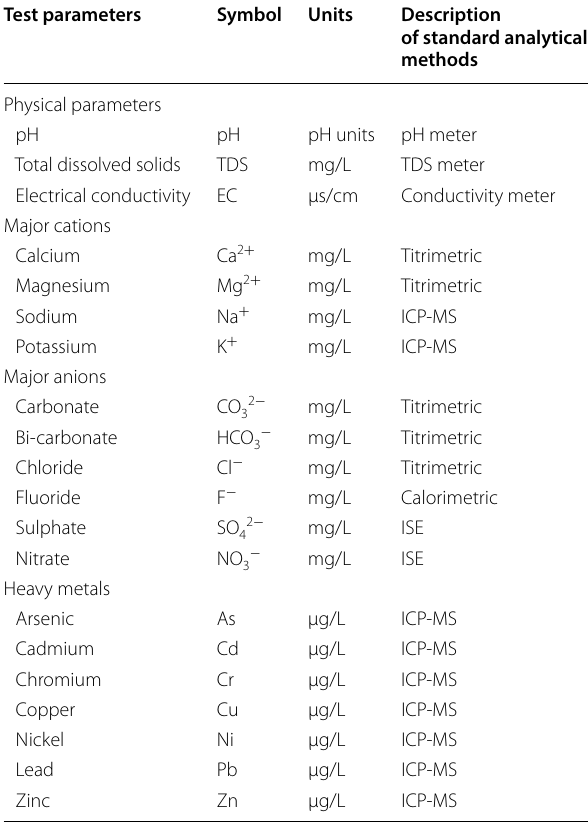
Table 2 Standards and method of analysis Test parameters